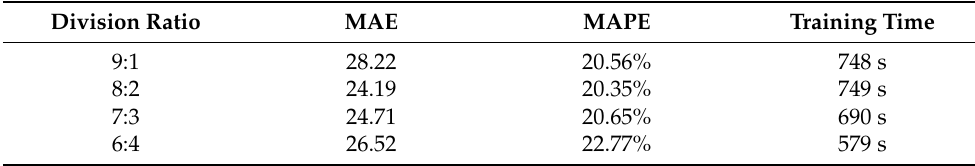
Table 6. Evaluation of model performance with different data division ratio with lstmunits set to 32 and epochs set to 10.